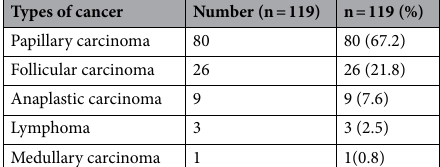
Table 2. Histological types of malignant